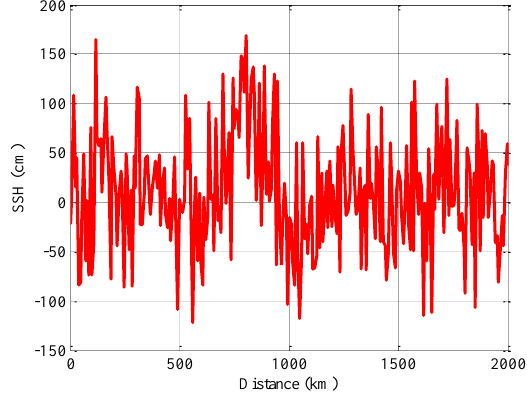
Figure 3. Modeled SSH measurements by adding noise of STD of 50 cm to Envisat SSH data.